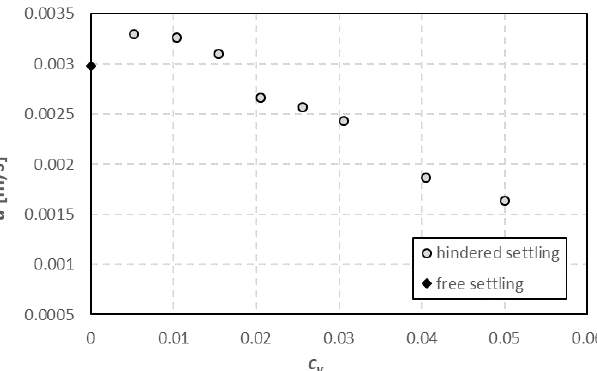
Figure 5. Settling velocity of fibers in glycerine depending on their volume concentration in the suspension cloud.